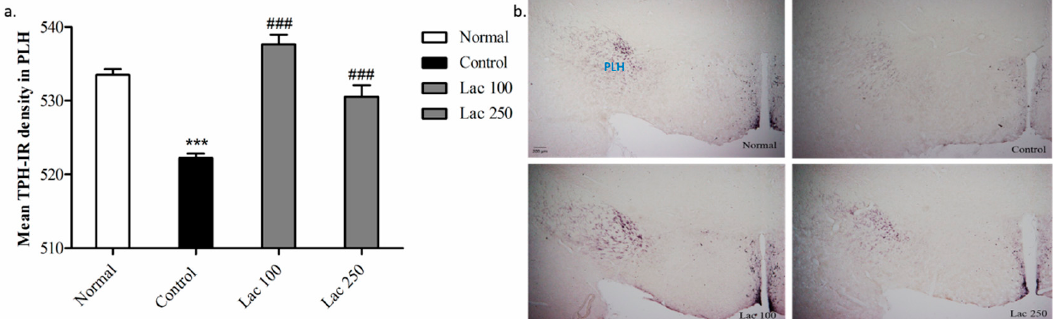
Figure 8. Changes occurred in TPH expression in the peduncular part of the lateral hypothalamic (PLH) following oral lactate administration. ( a ) The mean TPH-IR cell density was significantly increased in both the lactate 100 and 250 groups in comparison to the control group. Values are presented as mean ± SEM. *** show differences between the normal and control groups, ### show significant differences between the control group and treatment groups. ### p < 0.001. The p -value of the test was <0.001 by one-way ANOVA, followed by a post hoc LSD test ( n = 6). ( b ) Representative images of TPH+ cell expression in lateral hypothalamic region (magnification 40×).